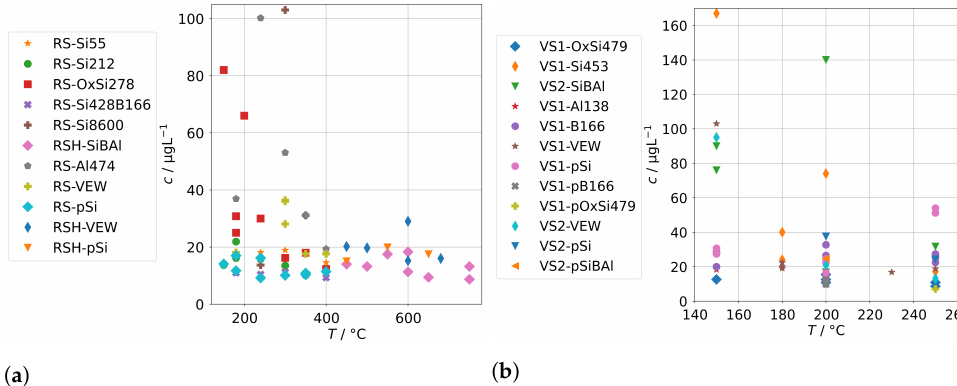
Figure A1. Sodium concentrations in steam condensates (includes clean and spiked feed-waters): ( a ) for the AG-SG; ( b ) for the two SB-SGs.